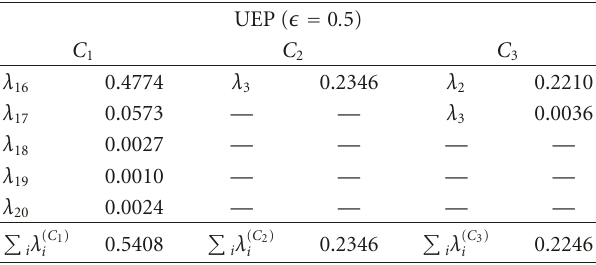
Table 3: Degree distributions for the di ff erent classes with (cid:2) = 0 . 5. R = 1 / 2.